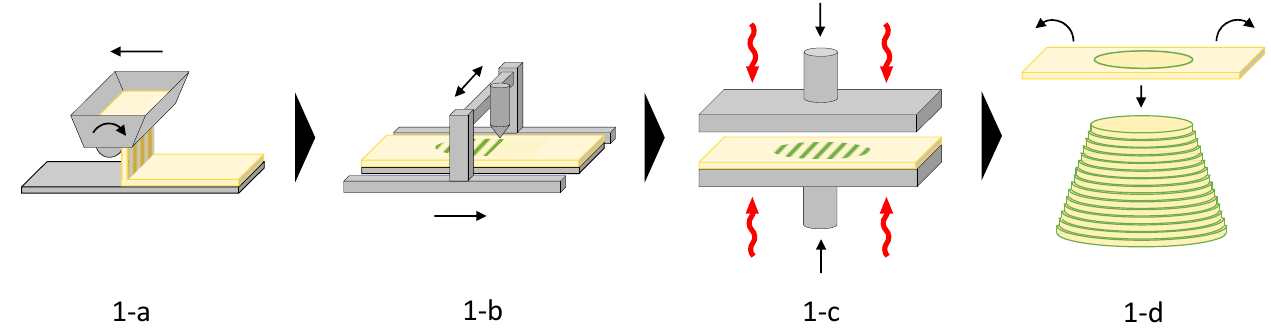
Figure 1. Schematic of the basic individual layer fabrication (ILF) process. Particles are spread in a thin layer on a base by a scattering device ( a ). On this particle bed, a liquid adhesive is applied locally, limited to those areas that are intended to be bound ( b ). The particle adhesive layer is then pressed, potentially under the influence of heat, and a panel with bound and unbound bulk material is obtained ( c ). Finally, the unbound bulk is removed, and the completed panel is transferred and laminated onto the stack of the previously fabricated panels ( d ).